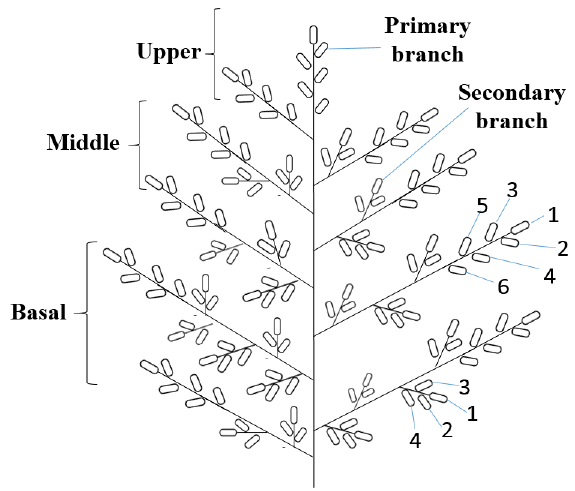
Figure 1. Diagram of rice panicle and grain growing position.